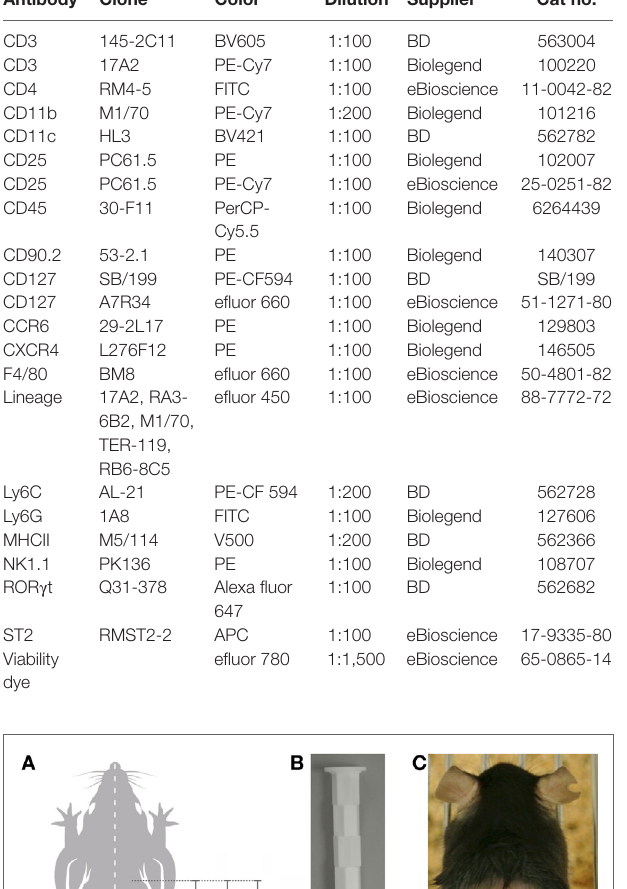
well three times pelleting cells by centrifugation in each wash step prior to discarding supernatant. Upon completion of extracellular